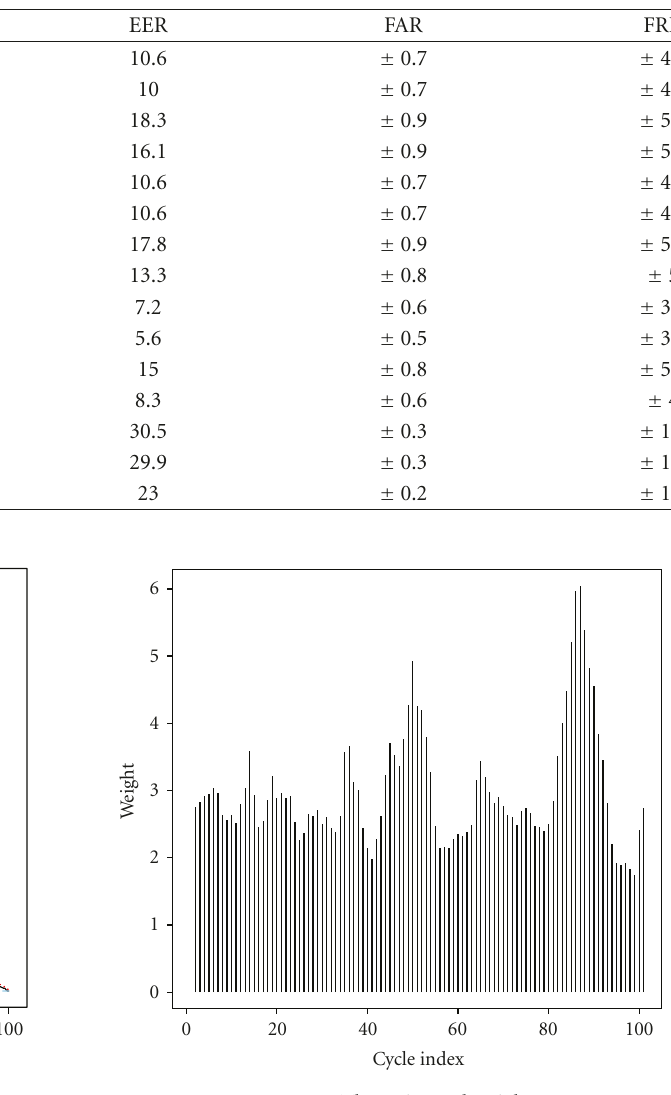
Figure 12: The estimated